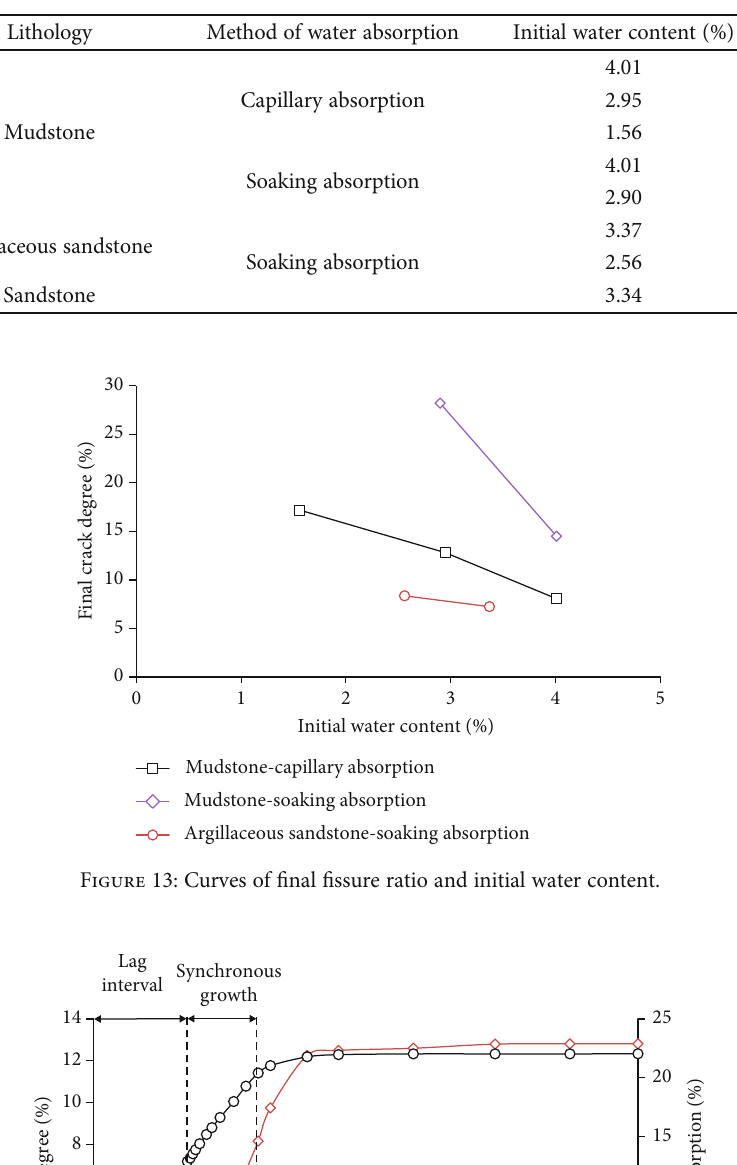
Table 3: Final crack degree of